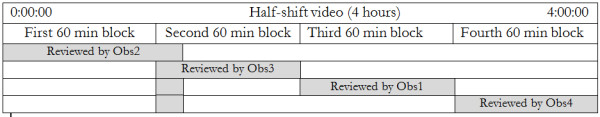
Example of the allocation of the shift between four observers, including the ‘overlap’ section to assess inter-observer agreement.